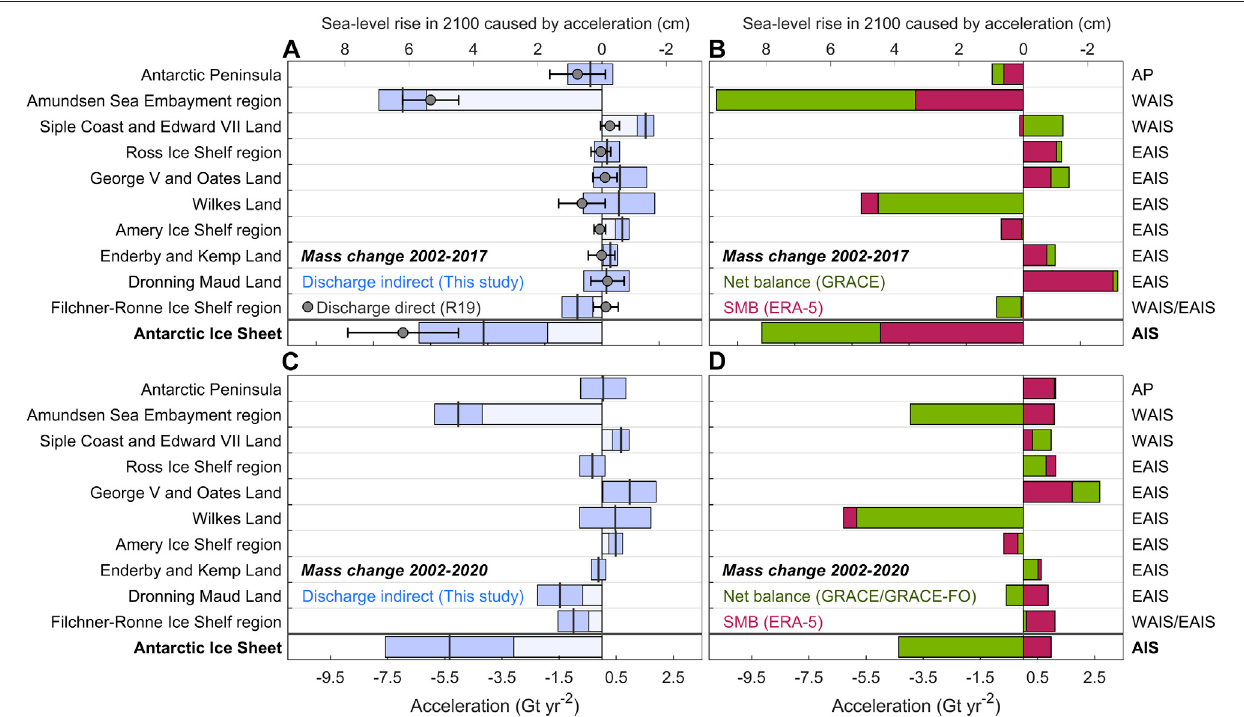
FIGURE 5 | Acceleration of cumulative ice-dynamic discharge for ten regions in Antarctica. (A) The acceleration of cumulative discharge, € D , from the indirect method (this paper; blue) is compared to published values based of the direct method of (Rignot et al., 2019a) (R19; circles), and, related to (B) acceleration of mass € € change, M (green), and acceleration of cumulative surface mass balance, SMB (red), for the time period 2002 to 2017. (C,D) exhibit results for the extended time period 2002to2020(nodatafromthedirectmethodavailable).Uncertaintyrangesre fl ect1- σ standarddeviations.ValuesfortheentireAntarcticIceSheetarescaledbya factorof10 − 1 forplotting.MasschangevaluesarerepresentedasGtyr − 2 (bottomaxis;denotedaccordingto Eq.2 )andasextrapolatedcontributiontosea-levelchange by 2100 in cm (top axis), assuming 360 Gt ofmassloss raise global mean sea level by 1 mm. Uncertaintiesfor each componentand the direct discharge estimate (Data availability) are shown in Supplementary Figure S5 . Results of the t- Test for signi fi cance are indicated in Supplementary Table S2 .